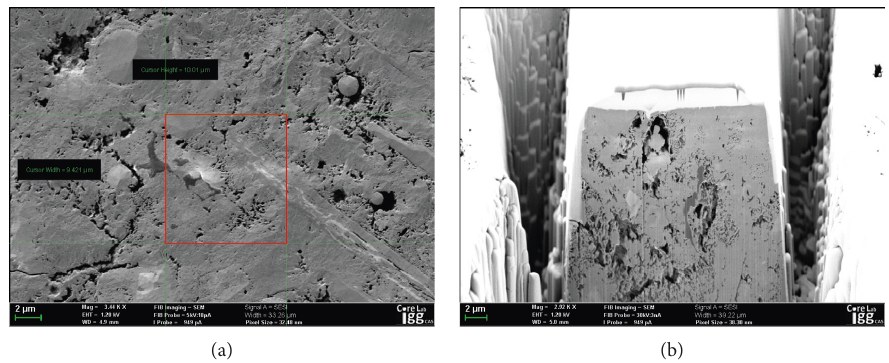
Figure 2: Process of FIB/SEM imaging: (a) aimed surface in 2D SEM; (b) cropped cross section of cement